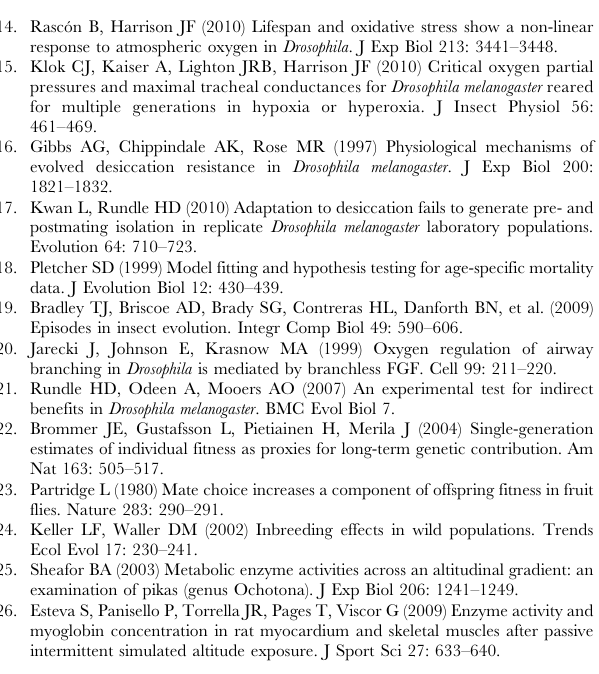
Figure S3 Mirrored gas chromatographic traces show- ing the cuticular hydrocarbons of male (red) and female (blue) D. melanogaster . Individual CHCs that were integrated are sequentially numbered within the profiles of each sex. Unlabelled peaks were not consistently present in all individuals of that sex and were not integrated. Table S1 Treatment effects on male and female cutic- ular hydrocarbons (CHCs) at generation 33(28 hyperox-